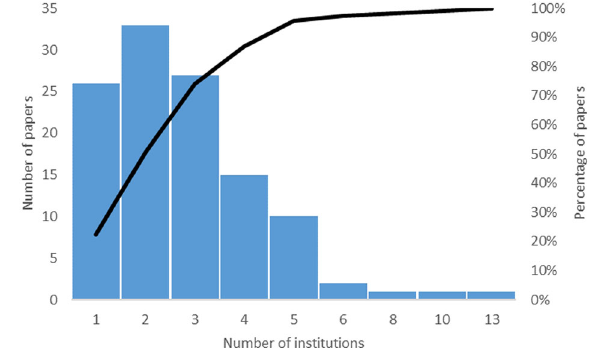
Fig. 10 Number of institutional co-authorships of journal